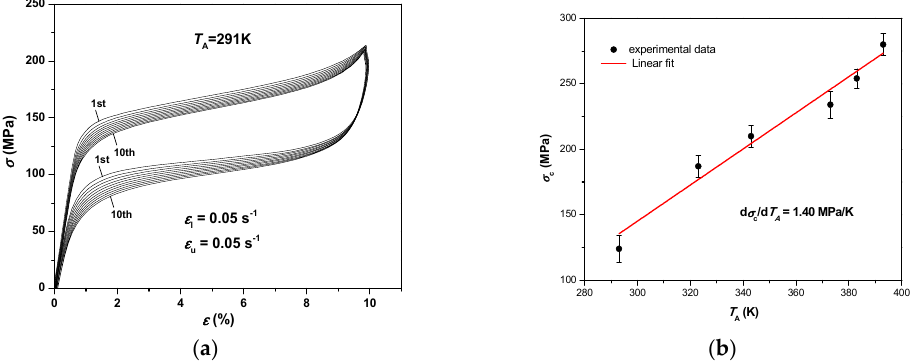
Figure 4. ( a ) Stress-strain curves with constant loading rate ( ε(cid:4662) l = 0.05 s − 1 ) at 291 K; ( b ) T A dependence of σ c for the columnar-grained Cu 71 Al 17.5 Mn 11.5 shape memory alloy (SMA).